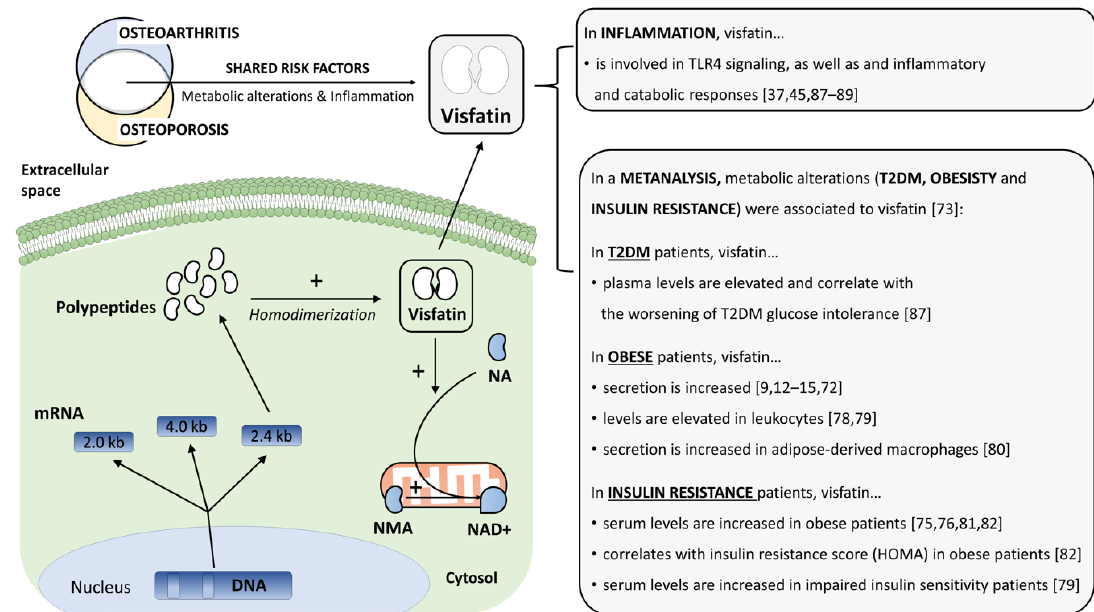
Figure 2. Visfatin Interaction with Osteoarthritis (OA) and Osteoporosis (OP) Risk Factors. Intracellular visfatin synthesis and its enzymatic activity. Among the shared risk factors between OA and OP, stand inflammation, and several metabolic alterations (type 2 diabetes mellitus (T2DM), obesity, and insulin resistance). Interestingly, both risk factors are associated to visfatin, a life-essential enzyme. Nicotinamide (NA); nicotinamide mononucleotide adenyltransferase (NMA); nicotinamide adenine dinucleotide (NAD+).